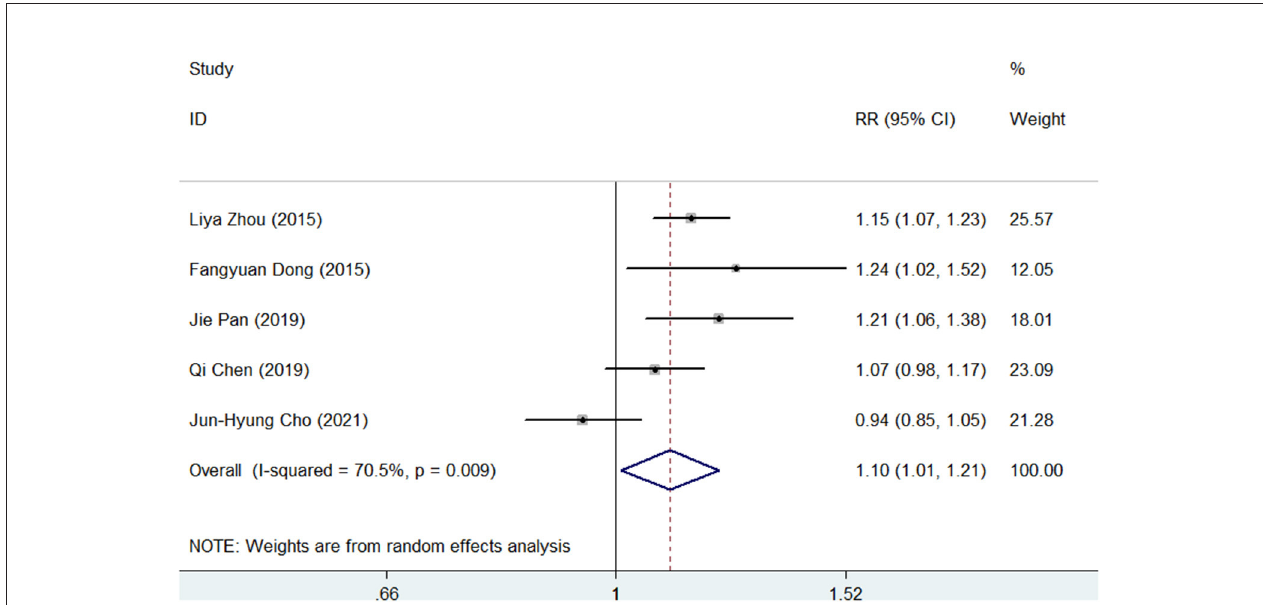
FIGURE 2 | Forest plots for the comparison of susceptibility-guided therapy (SGT) vs. bismuth-containing quadruple therapy (BQT) in Helicobacter pylori eradication by an intention-to-treat (ITT) analysis.